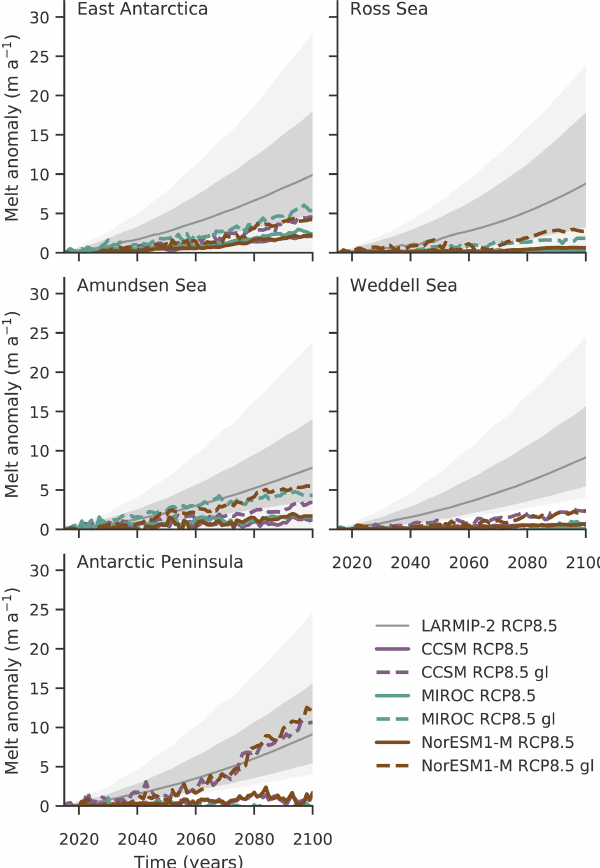
Figure 4. Projected basal melt rate changes in the different Antarc- tic regions from LARMIP-2 and in the ISMIP6 contribution forced with NorESM1-M, CCSM and MIROC ocean changes under RCP8.5. In LARMIP-2 spatially constant basal melt rate forcing is applied with corresponding very likely ranges (5th to 95th per- centiles, light gray shading), likely ranges (66th percentile around the median, dark gray shading) and median (gray line) for the RCP8.5 scenario. In the ISMIP6 contribution, basal melt rates are calculated by PICO, which shows higher increases close to the grounding line (PICO box 1, indicated by “gl”) than averaged over the ice shelves. Figure is similar to Fig. 3 in Levermann et al.